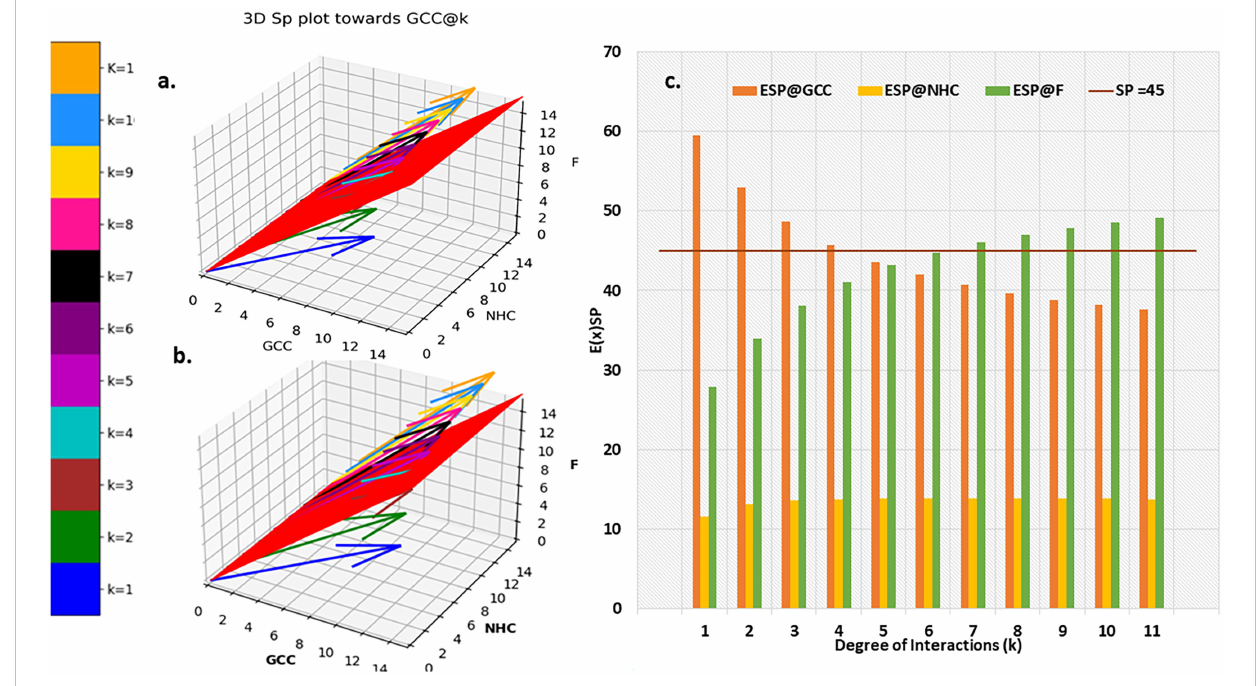
FIGURE 6 Probabilistic Expected Directional preference. (A) 3D S p plot @ k interactions towards (B) Resultant E(x) k of S p,k (C) comparison of E(x) k of S p,k for GCC, NHC and